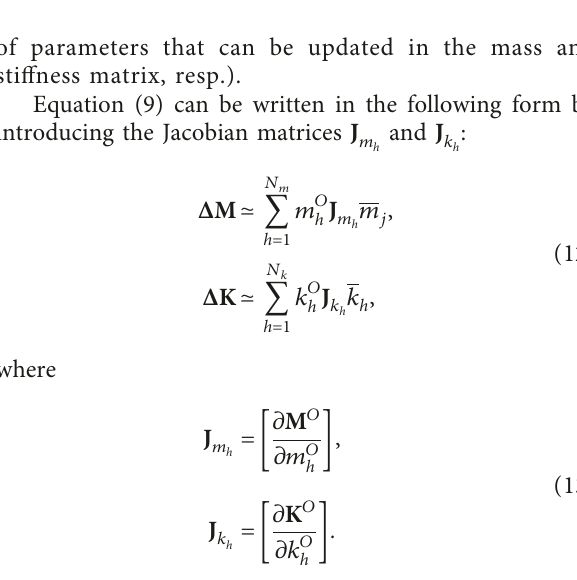
Figure 2: Interpretation of the analytical and experimental